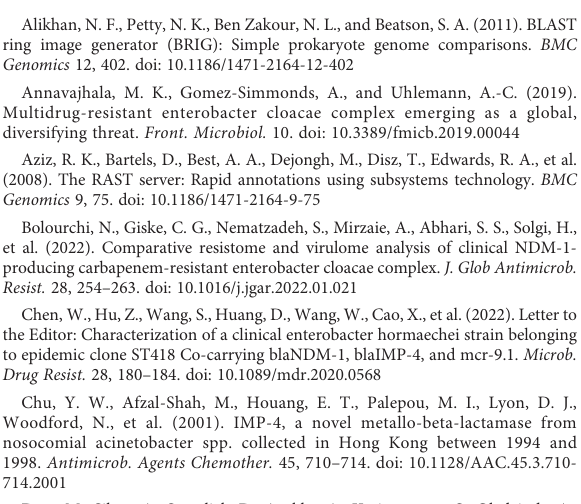
SUPPLEMENTARY FIGURE 6 The phylogenetic tree of 167 strains ECC based on the blaIMP resistance genes, generated by kSNP3.0 plus E. hormaechei YQ13422hy (Biosample SAMN28918927) and YQ13530hy (Biosample SAMN28919657). The sources of strains are identi fi ed as clinical. We used different colors to represent different meanings. The seven circles around the phylogenetic tree indicate the species (inner circle), ST type, IMP-type, host, location, year, and source (outer circle) of these strains. We marked YQ13422hy and YQ13530hy in